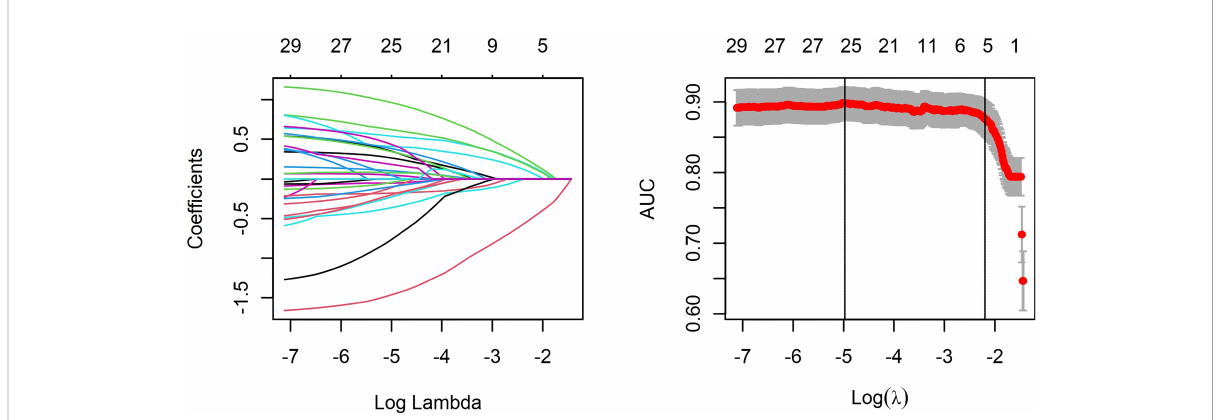
FIGURE 2 Least absolute shrinkage and selection operator (LASSO) regression and variable selection. All features were normalized by Z-score to remove the dimension divergence among the observational variables. In the cross-validated error plot, 25 variables with non-zero coef fi cients were selected at minimum cross-validated error, while fi ve variables with non-zero coef fi cient remained at minimum cross-validation error within 1 standard error of the